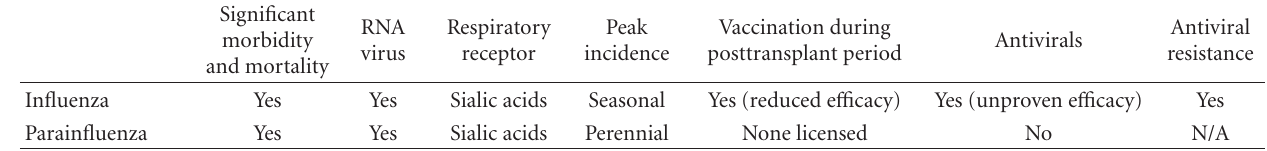
Table 1: Similarities and di ff erences between IFV and PIV infections in the immunocompromised host.